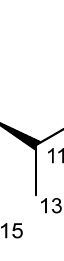
Figure 1. Chemical structure of faurinone.